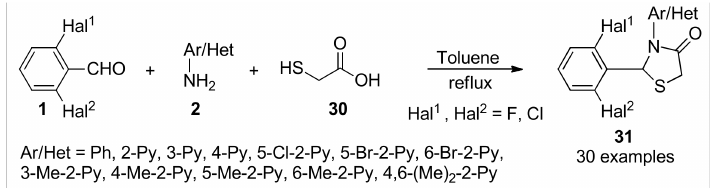
Scheme 11. Three-component synthesis of 2,3-diaryl-1,3-thiazolidin-4-ones 31 for structure-activity relationships, molecular modeling and studies as potent anti-HIV agents.